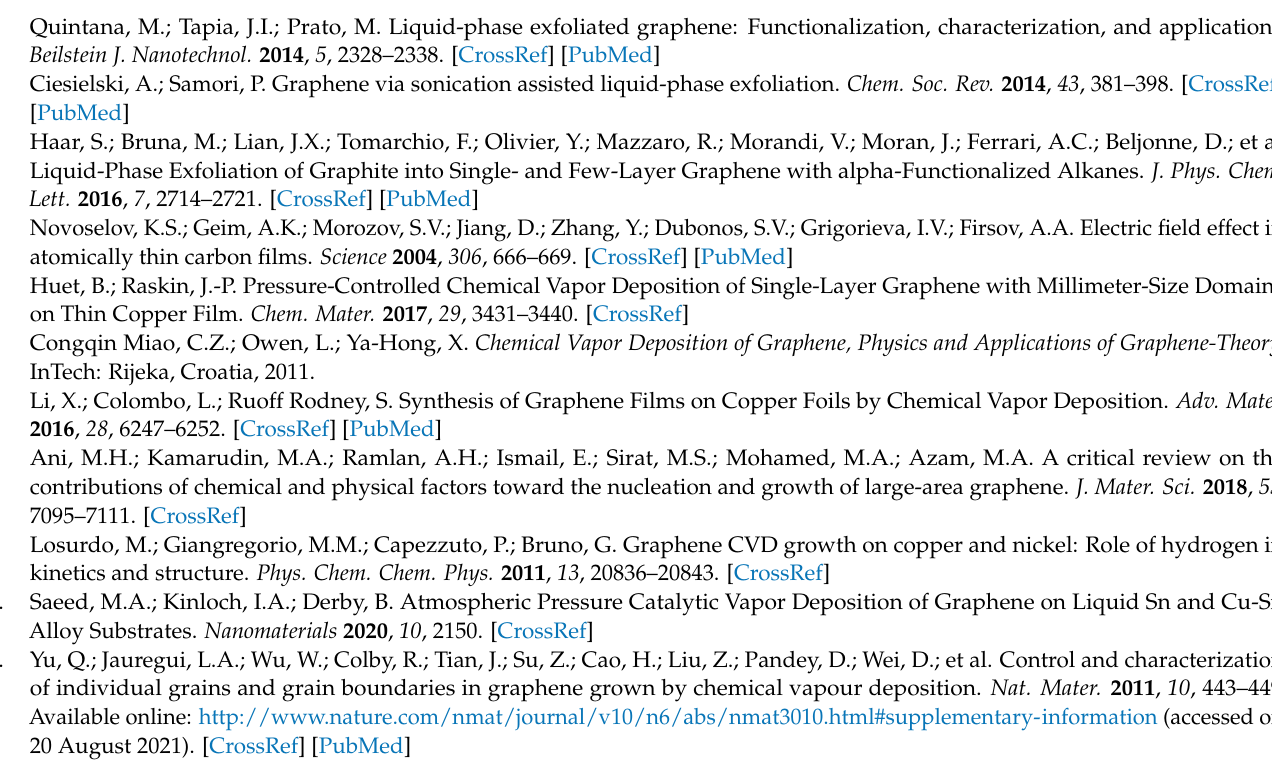
elemental metal used to form each Cu-In alloy composition, Table S2: Summary of the used APCVD graphene growth parameters on liquid In to study the effect of CH 4 concentration and residence Table S4: APCVD graphene growth parameters on liquid In using different Ar flow rates, Figure S2: Photograph showing the position of the sample in the APCVD reactor in the middle of the furnace hot zone while the sooty patch where graphene was deposited on the surface is shown as observed, towards the exhaust end of the reactor, Figure S3: APCVD graphene grown on liquid In using Ar flow rate of 1000 sccm and a growth time of 15 min. (a) Optical image of the graphene film showing three regions noted by numbers where one has no graphene, two has early deposition and three is the grown graphene film. (b) Photograph of the CVD reaction tube that shows the change in its colour as it becomes less transparent. This shows that the growth time does not affect the degree of coverage but leads to a slight increase in the sooting of the reaction tube. Table S5: Optimised growth parameters for APCVD graphene on liquid